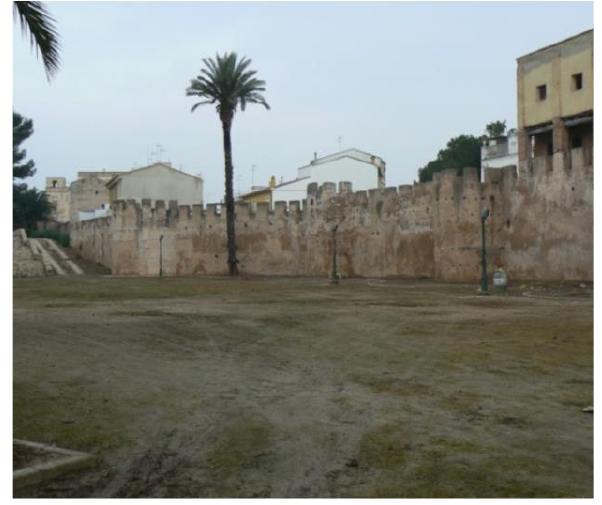
Figure 3. The Moorish wall (PEP –